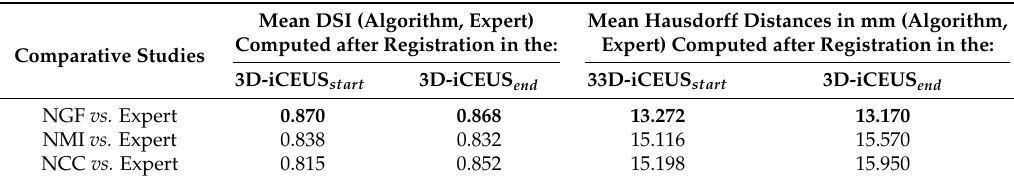
Figure 5. Illustration of vascular structures identification for five cases: ( a ) preoperative cT1MR; ( b ) vascular structure selection in cT1MR; ( c ) overlapping of vascular structure segmented in cT1MR on CEUS start before registration; ( d ) overlapping of vascular structure segmented in cT1MR on CEUS start after registration; ( e ) overlapping of vascular structure segmented in CEUS start on CEUS end before registration; ( f ) overlapping of vascular structure segmented in CEUS start on CEUS end after registration. Table 2. Mean DSI values and Hausdorff distances computed forthe three similarity measures and by comparison with the expert registration.